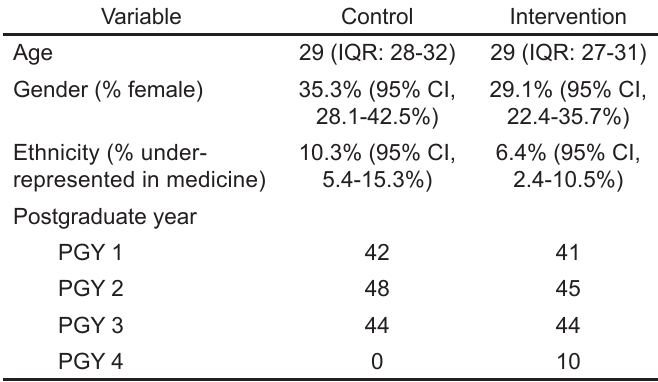
Table 1. Demographics of emergency medicine residents who responded to